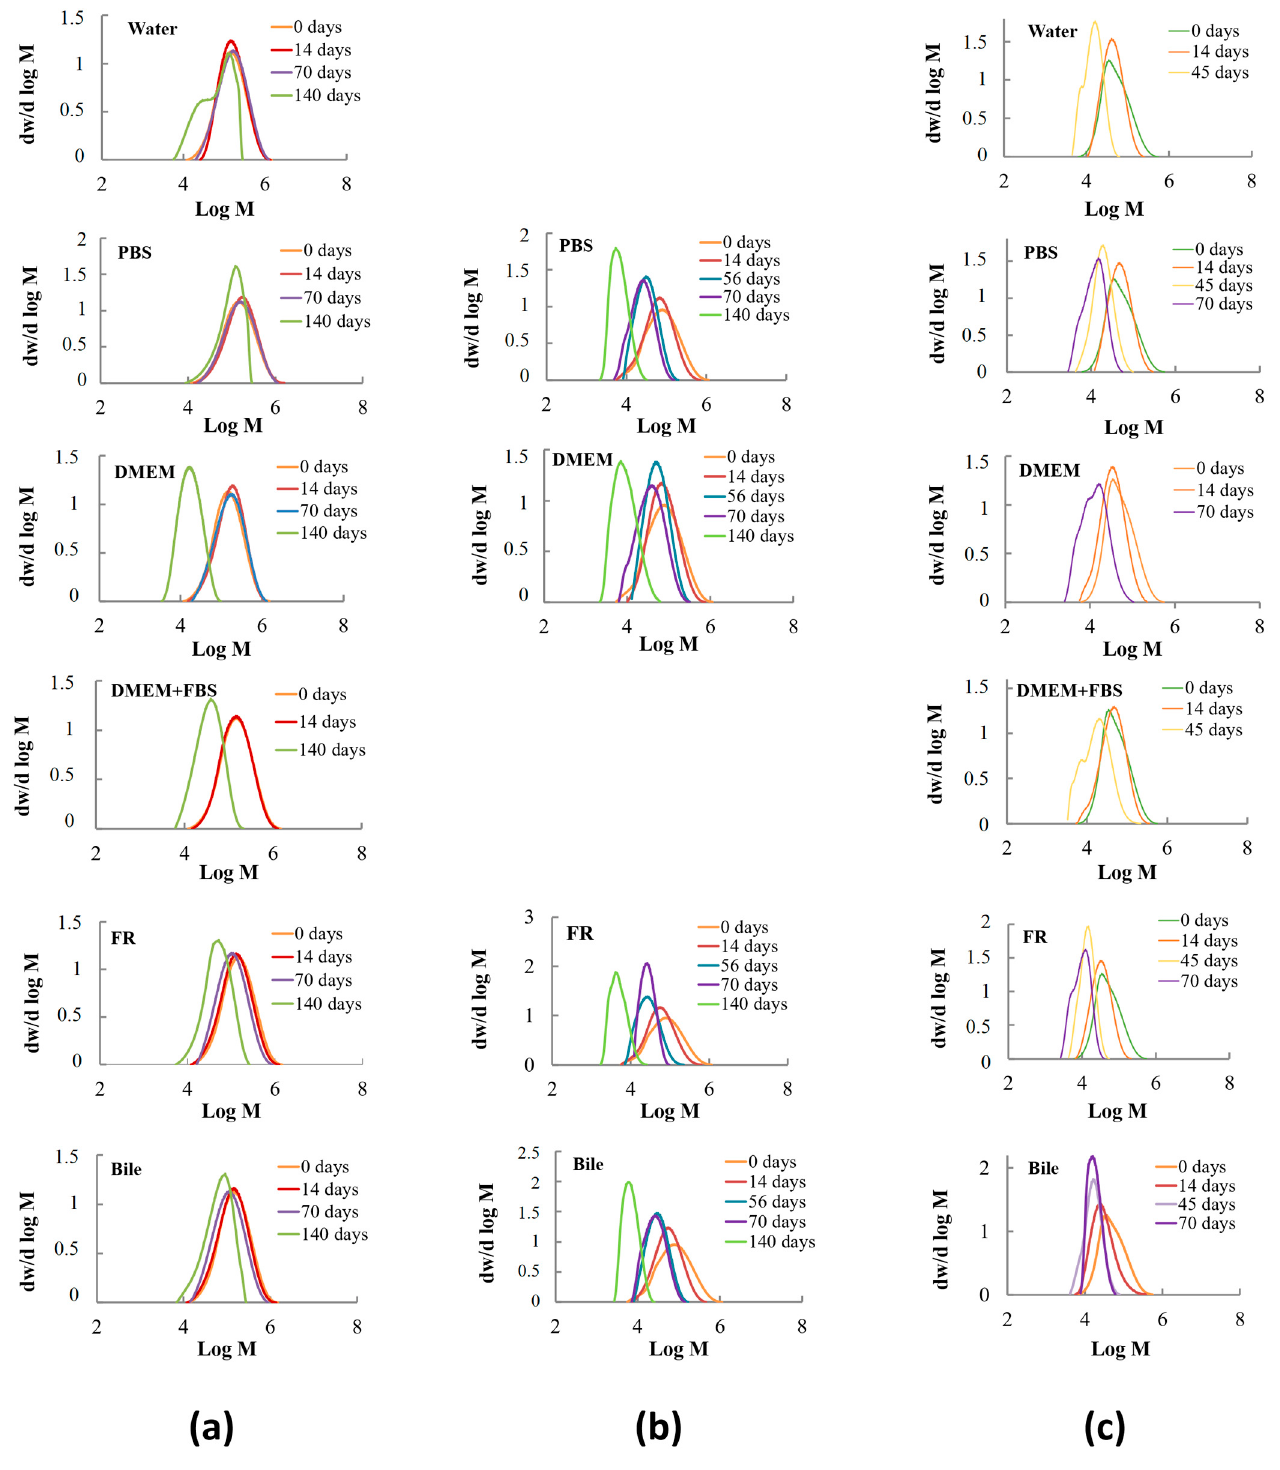
Figure 4. Variation of molecular mass distribution in biocompatible scaffolds derived from: ( a ) PCL; ( b ) PLCL; ( c ) PLGA depending on test media composition and degradation time.